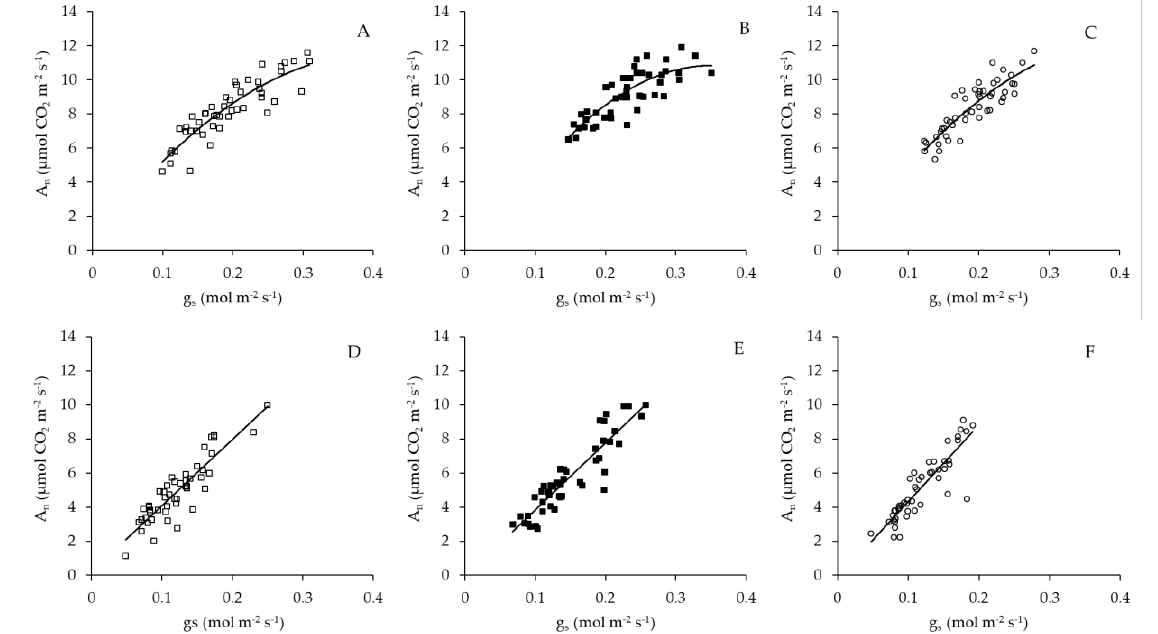
Figure 8. The response of photosynthesis rate (An) to stomatal conductance ( g s ) variations in ‘Fuji’ apple leaves grown in red (□), blue ( ■ ) and white control ( ○ ) nets measured under ambient light conditions before solar noon ( A – C ) and after solar noon ( D – F ), respectively. Table 5. Regression coefficients for the relationship between photosynthesis rate and stomatal